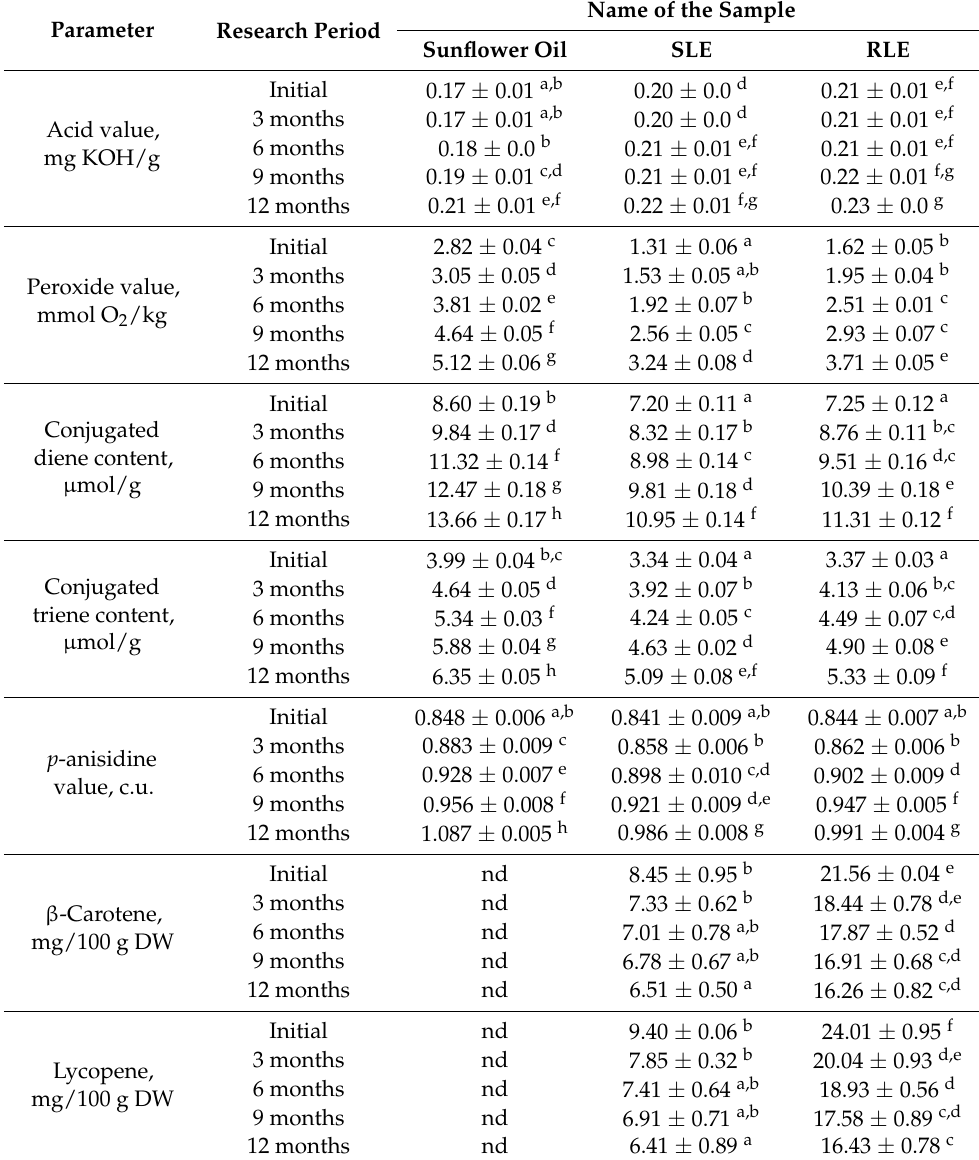
Table 4. Evolution of the physicochemical parameters and carotenoid content of the sea buckthorn and rose hip lipophilic extracts and sunflower oil during